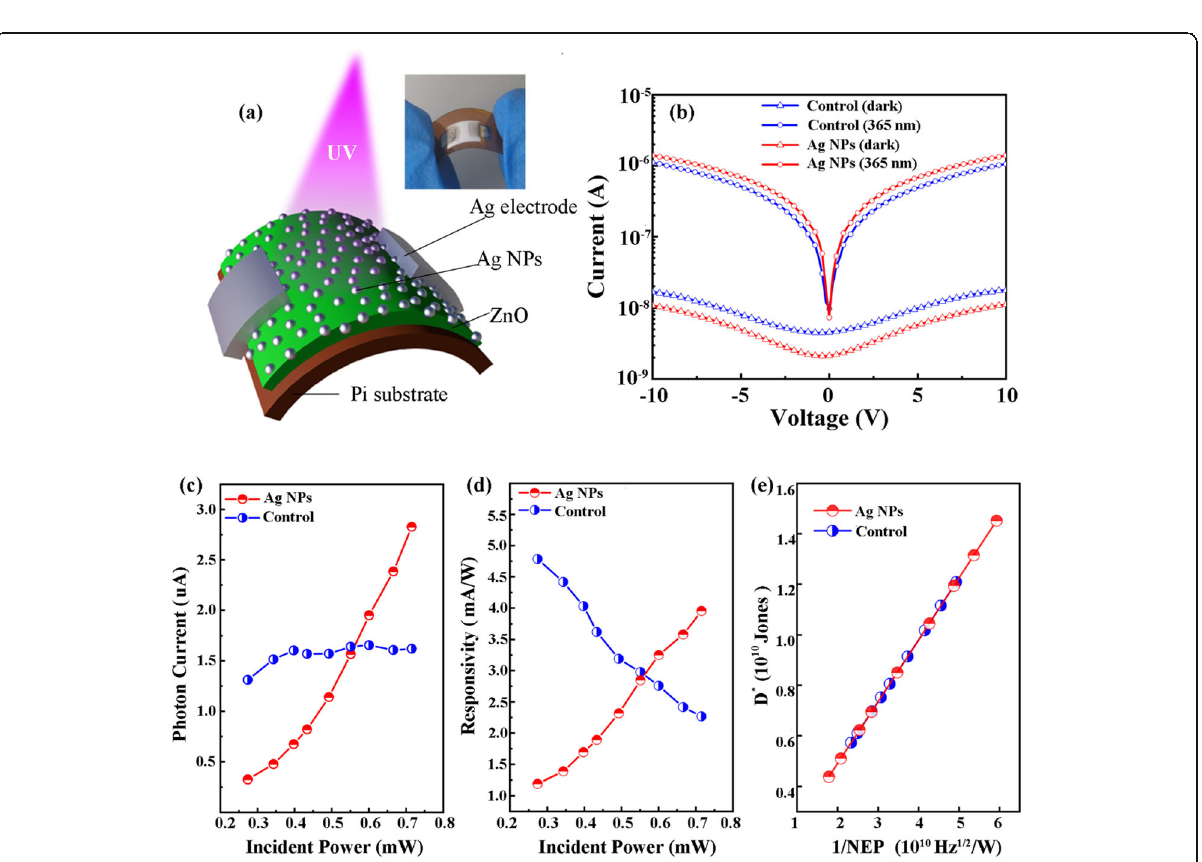
Fig. 3 a Schematic structure of Ag NP-modified ZnO UV photodetector and the inset is an optical image of fabricated UV photodetector by bending. b I-V characteristics in dark condition and 365 nm UV at 715 mW. c , d The tendency of photocurrent and responsivity with a different incident power and responsivity. e The relationship between normalized detectivity ( D *) and the reciprocal of NEP (1/NEP). Liu et al.